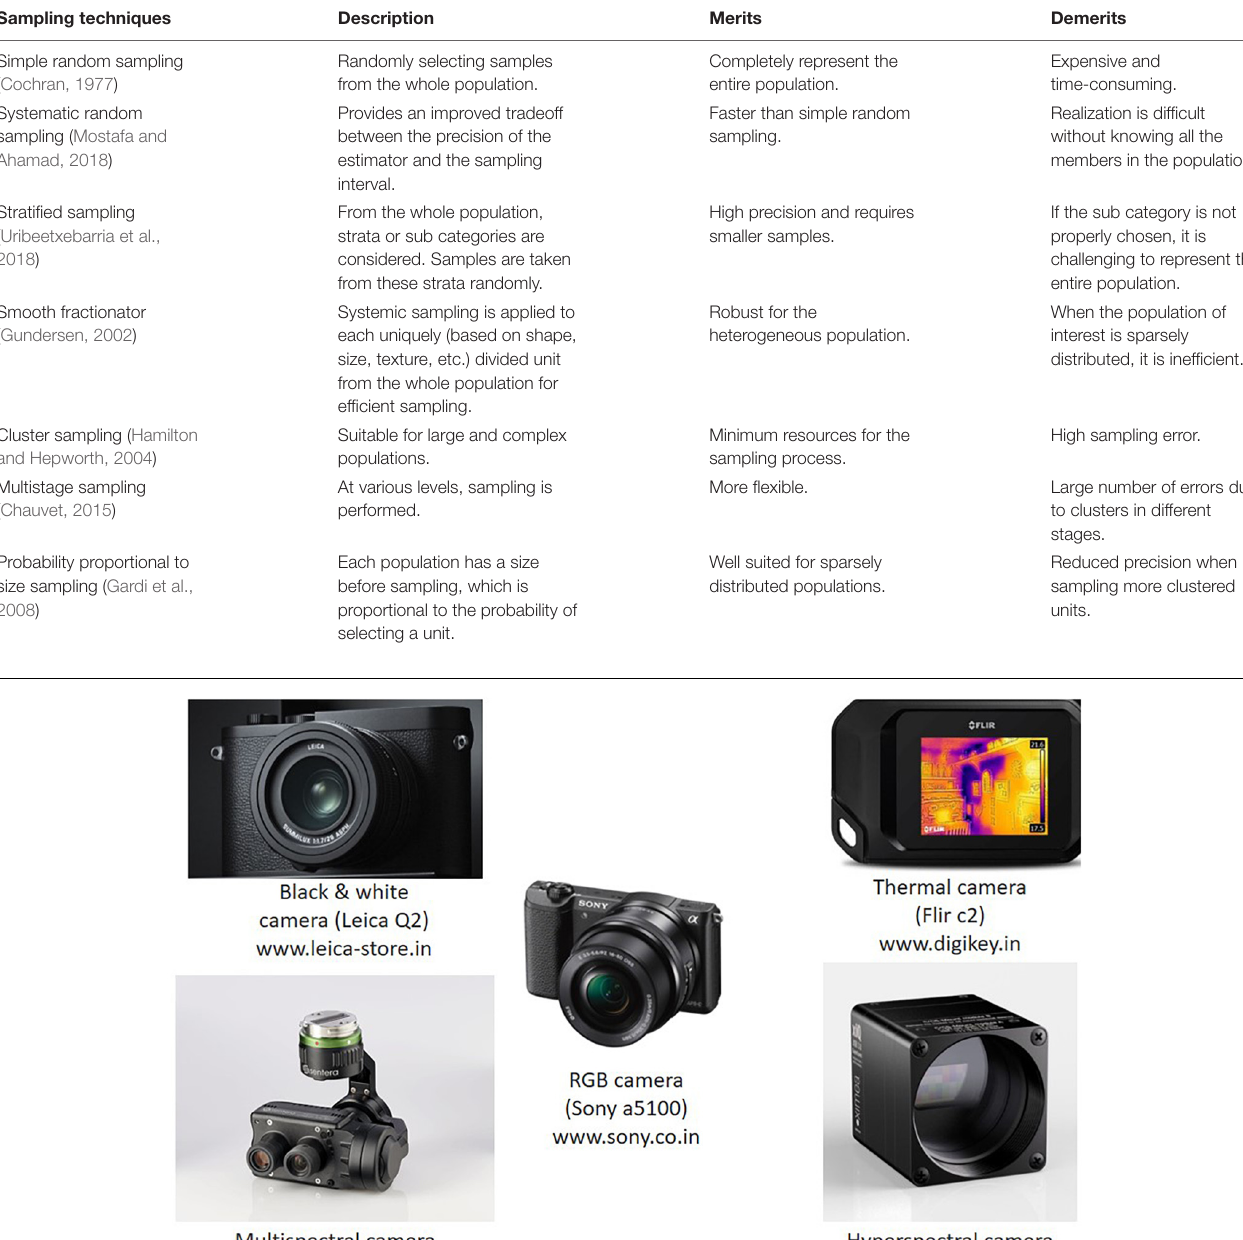
detection by capturing images using a thermal camera.